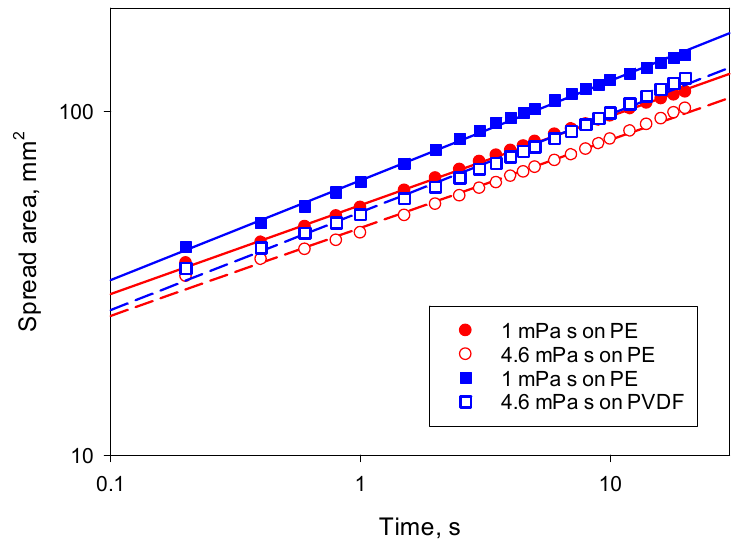
Figure 2. Spreading kinetics of silicone oils on polyvinylidenefluoride (PVDF) and polyethylene (PE).